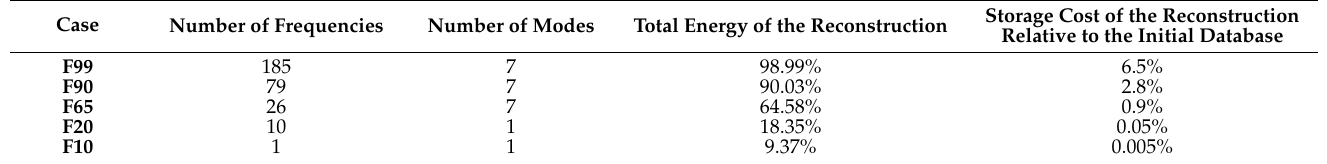
Table 2. Details of each reconstruction and the storage cost relative to the initial database.